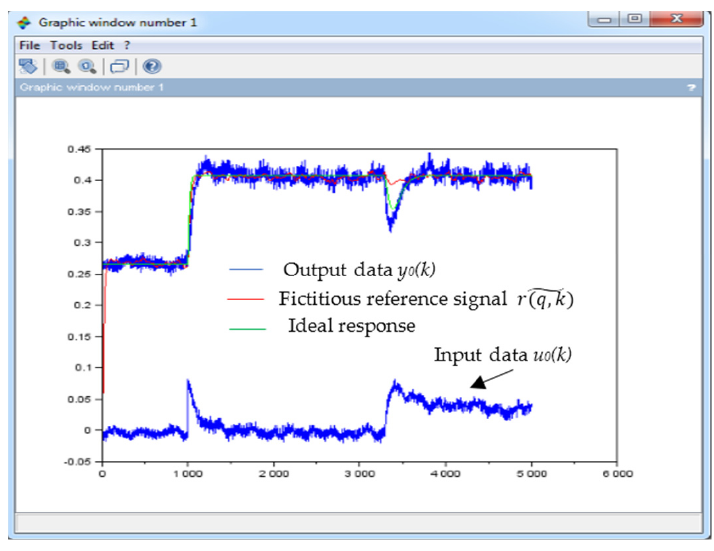
(cid:94) Figure 18. The state of fictitious reference signal (cid:1870)(cid:4666)(cid:1869), (cid:1863)(cid:4667)(cid:3563) after 10 iterations.